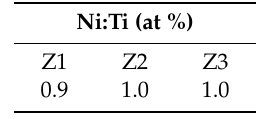
Figure 9. Powder micrographs ( a ) after debinding (SEM); ( b ) selected zones (Z1, Z2, and Z3) for the chemical composition evaluation (EDS). Table 4. Ni:Ti of powder after debinding in the selected zones (Figure